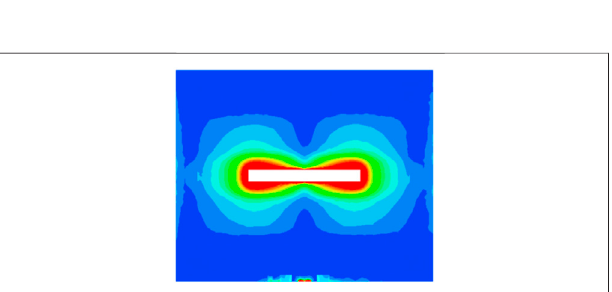
FIGURE 7 | Effective current distribution at 2.4